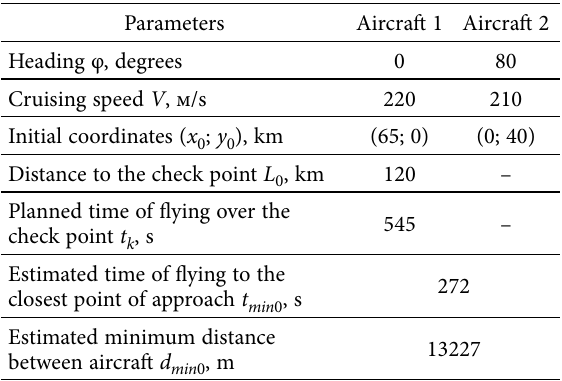
. The optimality criteria values